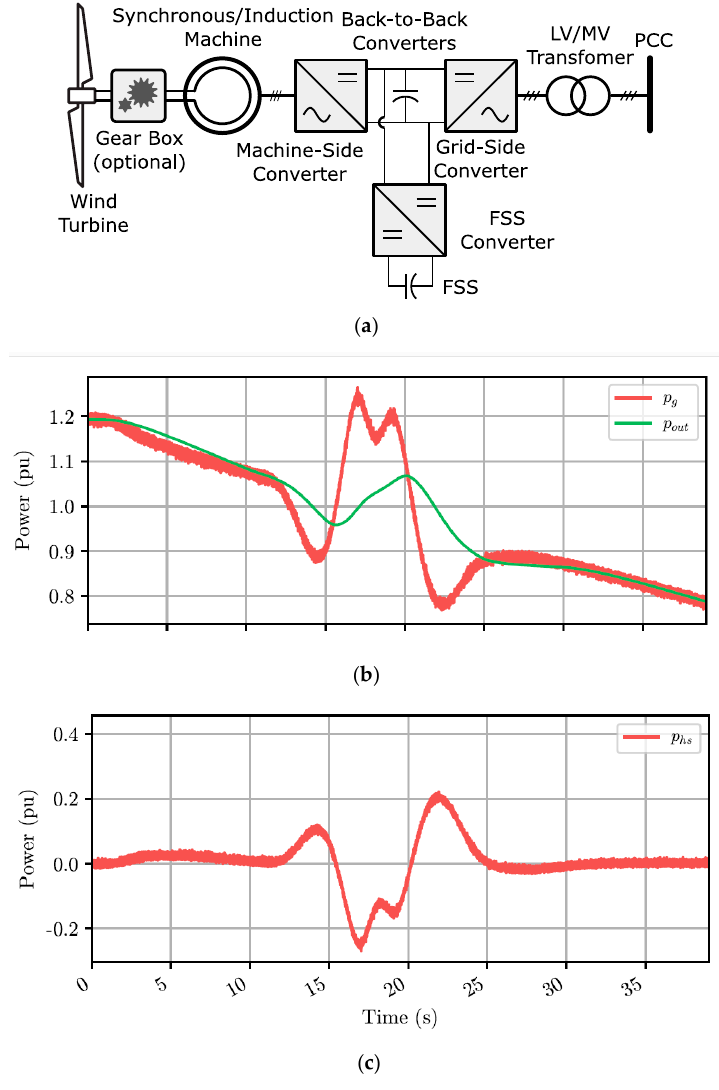
Table 1. Ramping reserve requirements [20].